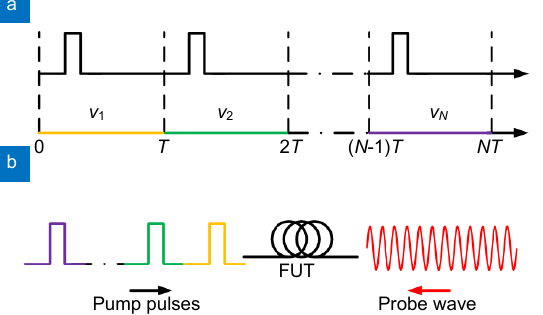
Fig. 1 | ( a ) Two modulation steps to obtain the frequency-scanning optical pulses. ( b ) The sequence diagram of the pump pulses and probe wave.